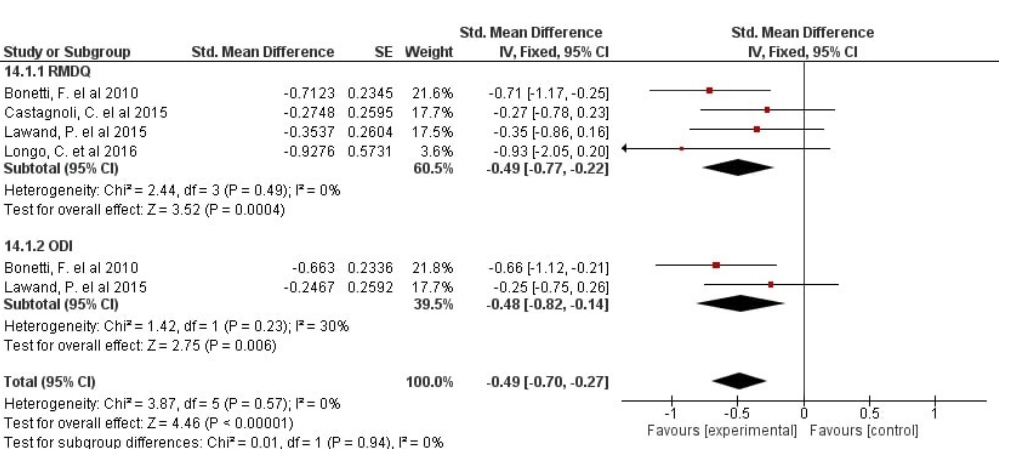
Figure 2. Effects of GPR on disability.